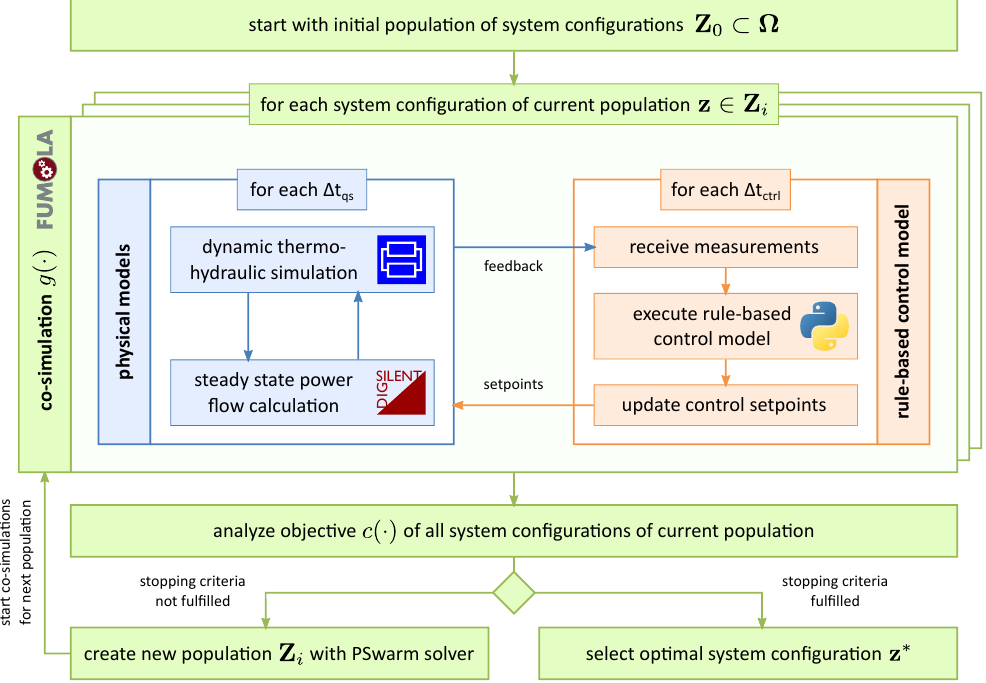
Figure 10. Schematic overview of the HPS workflow applied to the system design of the rural residential